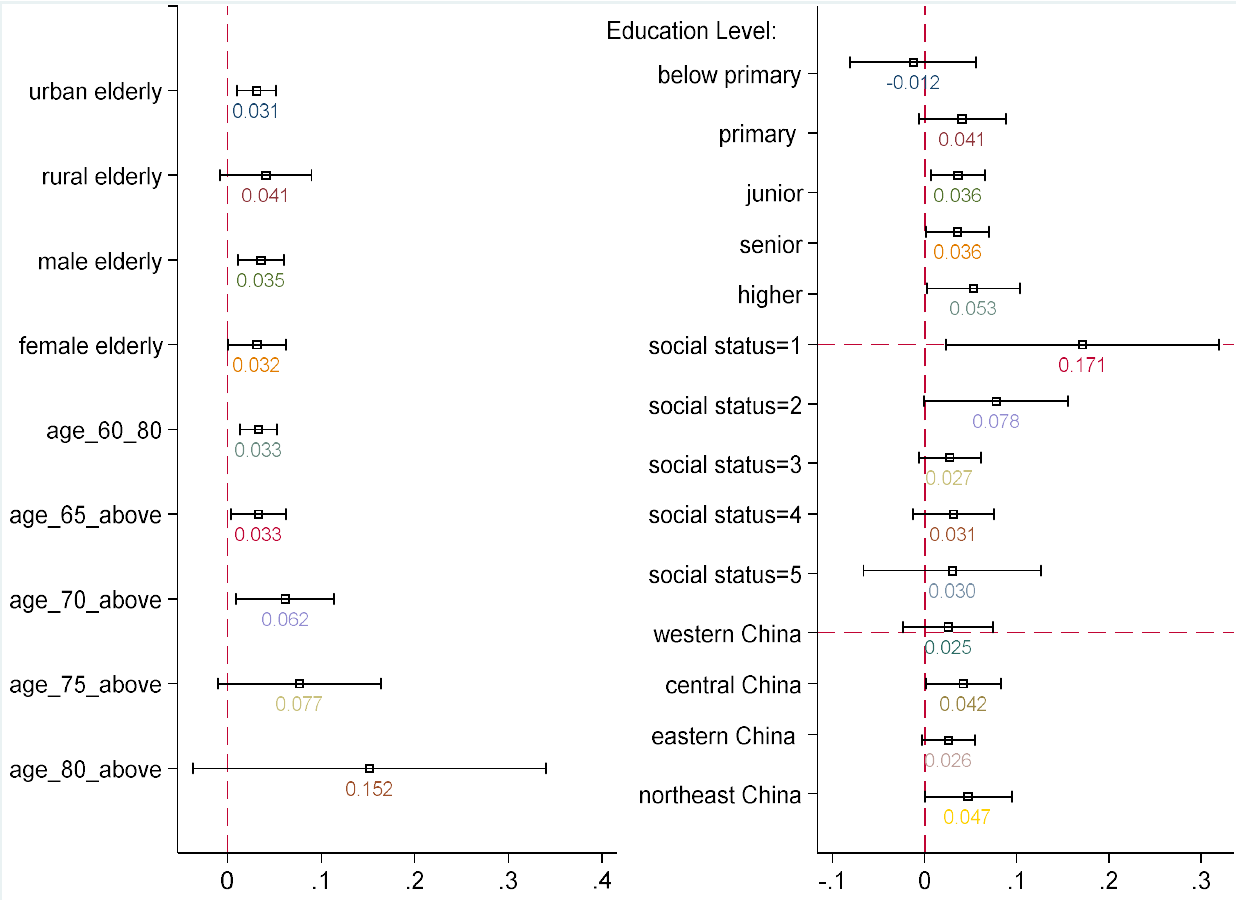
Figure 2. Heterogeneous effects of OSIs on older Chinese adults’ life satisfaction according to gender, residential status, age span, social status, education, and geographical area. Note: Other controls are the same as Table 2, and regressions of social status groups are not controlled for social status. Estimates of OSIs are reported in the figure with 95% confidence intervals. The regressions’ detailed results are presented in Tables A1 and A2 in Appendix A.